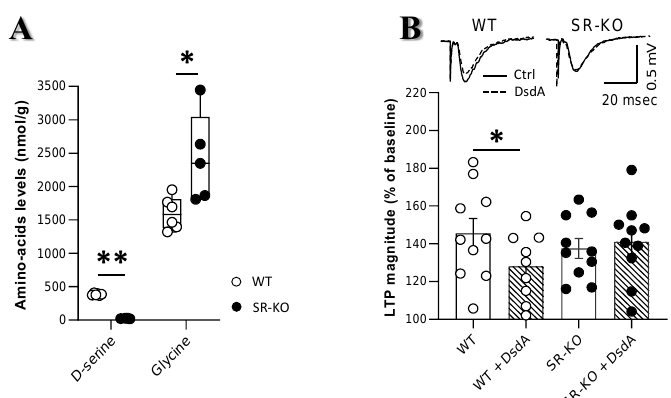
Figure 4. Changes in glycine levels contribute to preserving functional plasticity in SR-KO mice. ( A ). Comparison of d -serine and glycine levels (in nmol / g of hippocampal tissues) determined in WT ( n = 6) and SR-KO ( n = 5) mice. d -serine was mostly absent in the transgenic mice while glycine was significantly elevated (* p < 0.05 and ** p < 0.001 for Mann–Whitney test). ( B ). Superimposed traces of fEPSP slope after HFS stimulation in a slice from a WT (left) and SR-KO mouse (right) with or without d -serine deaminase (DsdA) respectively dashed line and full line. Comparison of mean LTP magnitude during the last 15 min in WT and SR-KO mice recorded in control aCSF ( n = 10 slices in both groups) and slices incubated with the DsdA to deplete d -serine levels ( n = 9 and n = 10 slices, respectively). LTP magnitude was significantly reduced by the d -serine depletion in WT mice while remained una ff ected in SR-KO mice (two-way ANOVA; * p < 0.05 for paired t test in the last 15